Question: Sum up the contents of this chart in one sentence.
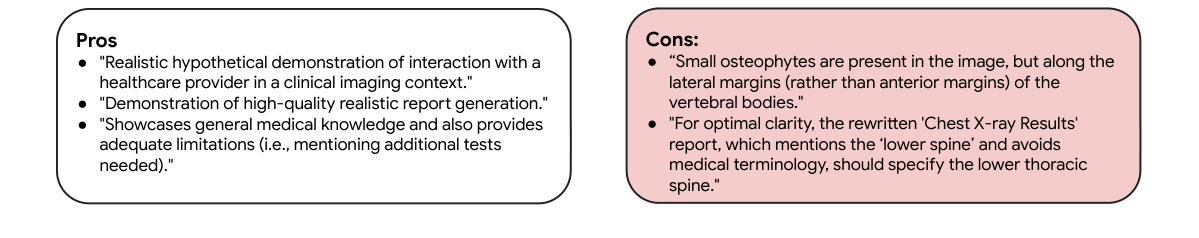
Answer: | Example of a hypothetical multimodal diagnostically-assistive dialogue with Med-Gemini-M 1.5 in the radiology setting. (a) In this interaction, Med-Gemini-M 1.5 demonstrates its ability to analyze a chest X-ray (CXR) and conduct a hypothetical realistic dialogue with a primary care physician. As above, Med-Gemini-M 1.5 is not suitable for this real-world use without further research. However, this example demonstrates initial promise, wherein Med-Gemini-M 1.5 identifies mild degenerative changes along the spine and can answer questions about the reasoning which led to this finding, demonstrate general medical knowledge about degenerative disk disease and distinguish between correlation and causation in relation to a patient history of back-pain. Finally, in this example Med-Gemini-M 1.5 is able to explain its findings in layperson’s terms, demonstrating its potential for facilitating patient understanding and communication in clinical settings. The ground truth report for th